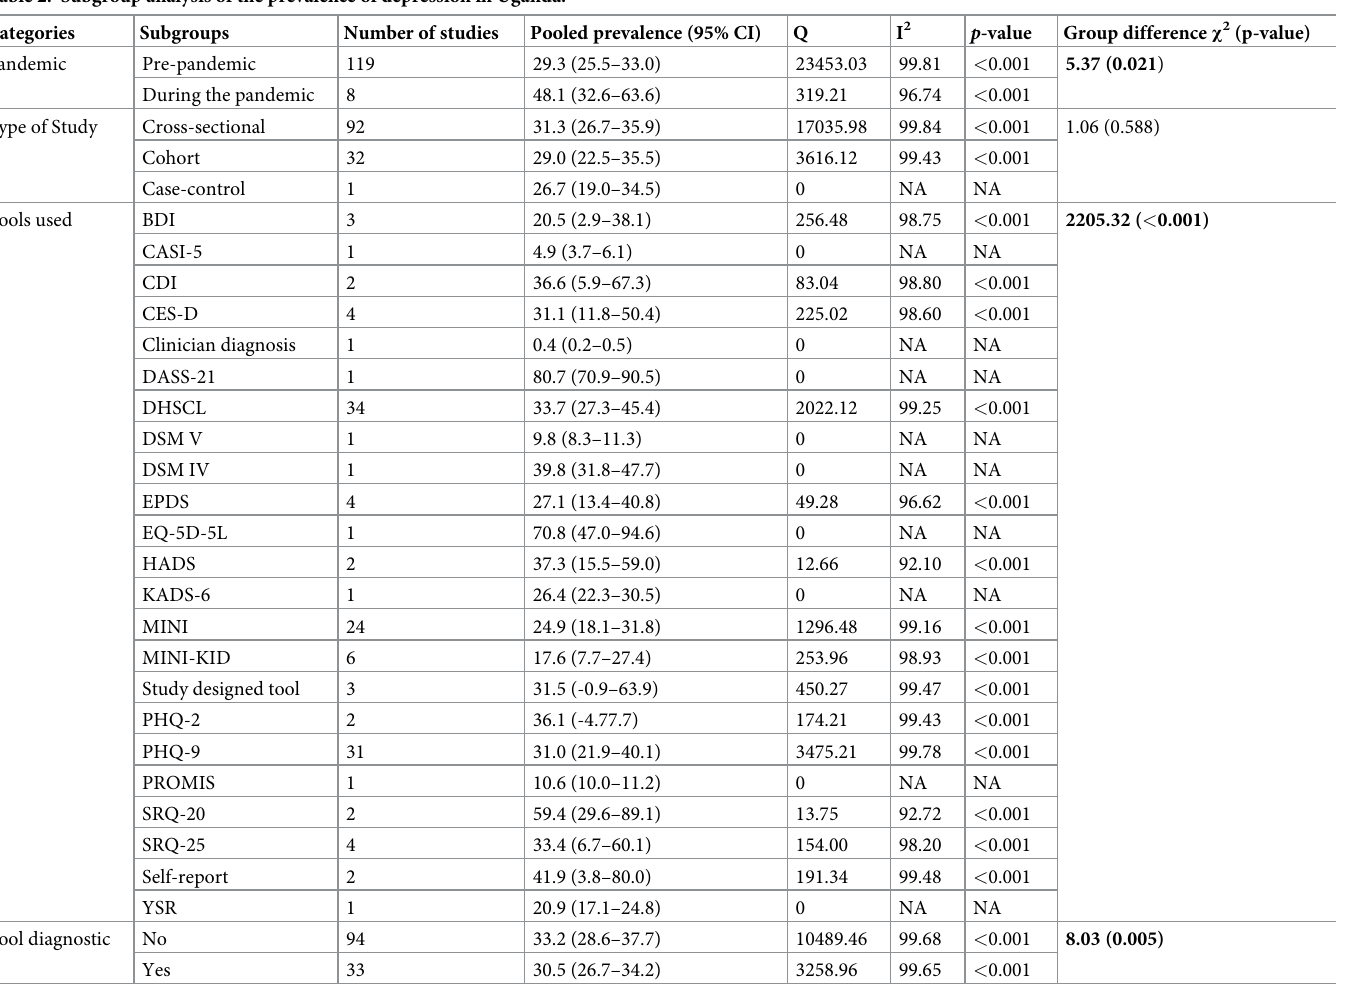
Table 2. Subgroup analysis of the prevalence of depression in